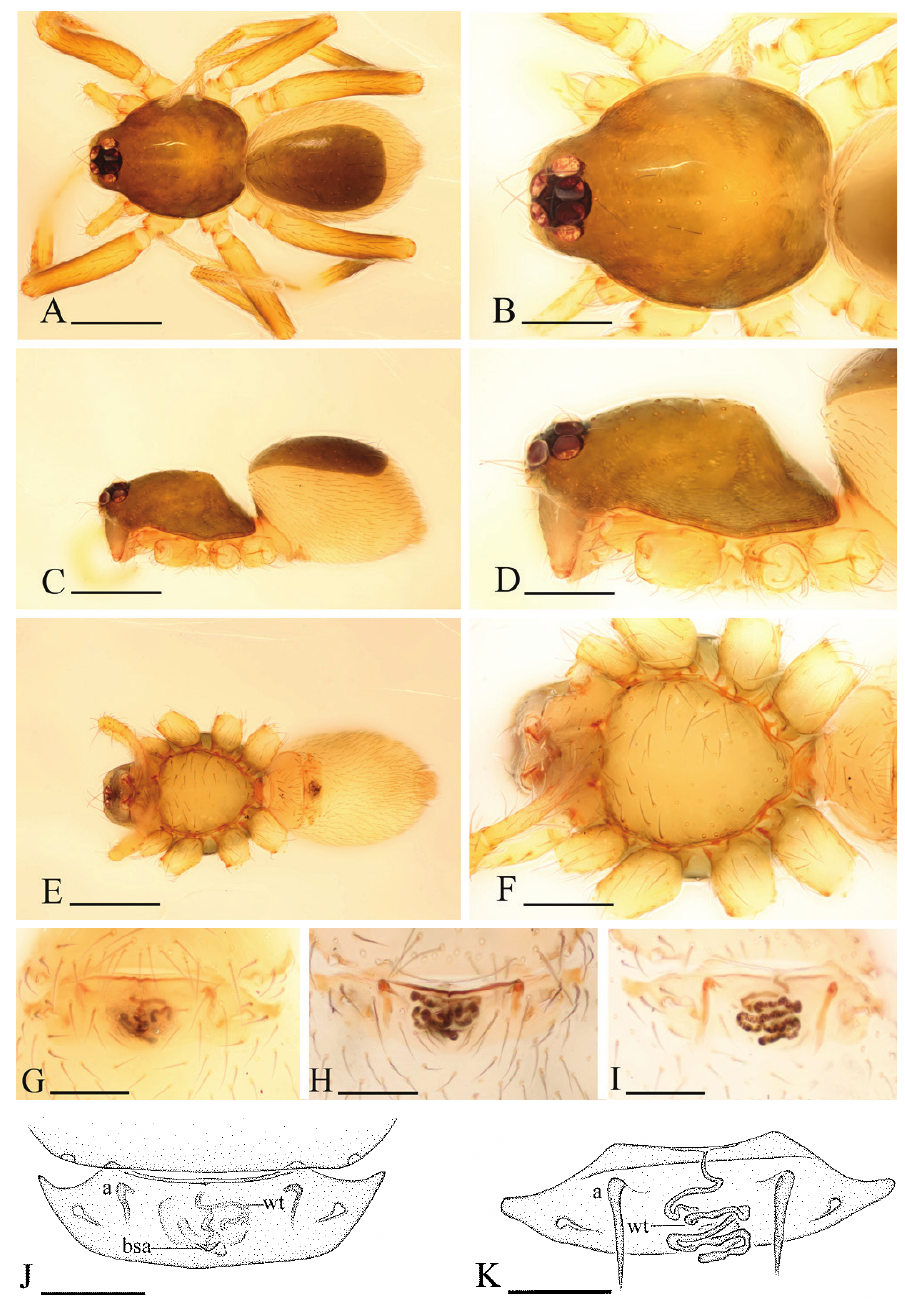
Figure 5. Ischnothyreus brunneus sp. n., female. A, C, E habitus, dorsal, lateral and ventral views B, D, F prosoma, dorsal, lateral and ventral views G, H, J epigastric region, ventral view I, K epigastric region, dorsal view (H, I cleared in lactic acid). Abbreviations: a = apodeme; bsa = bell-shaped atrium; wt = winding tube. Scale bars: A, C, E = 0.4 mm; B, D, F = 0.2 mm; G–K = 0.1